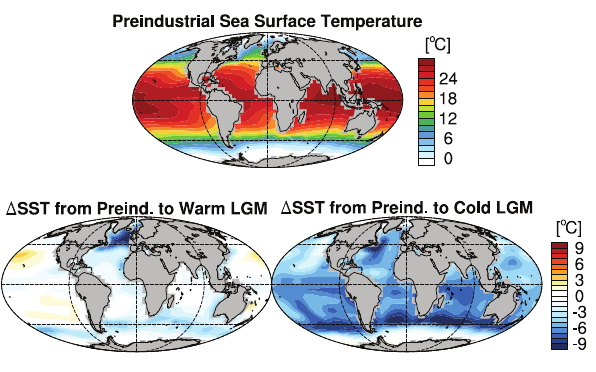
Fig. 2. Top panel shows preindustrial sea surface temperature Fig.2. Toppanelshowspreindustrialseasurfacetemperature(SST),asreconstructedbyproxies(Rayneretal.,2003).Bottomtwopanelsare theabsolutechangesinSSTduringthe warm-LGM (bottomleft;CLIMAP,1976)and cold-LGM (bottomright;Webbetal.,1997)scenarios, (SST), as reconstructed by proxies (Rayner et al., 2003). Bottom relativetothepreindustrial,withtheLGMcoastlinesandicesheets.Thedifferenceplotsshareacommoncolorbar.ThechangeinSSTfrom two panels are the absolute changes in SST during the warm LGM thepreindustrialtothepresentdayisrelativelysmall(notshown). (bottom left; CLIMAP, 1976) and cold LGM (bottom right; Webb et al., 1997) scenarios, relative to the preindustrial, with the LGM coastlines and ice sheets. The difference plots share a common color bar. The change in SST from the preindustrial to the present day is relatively small (not